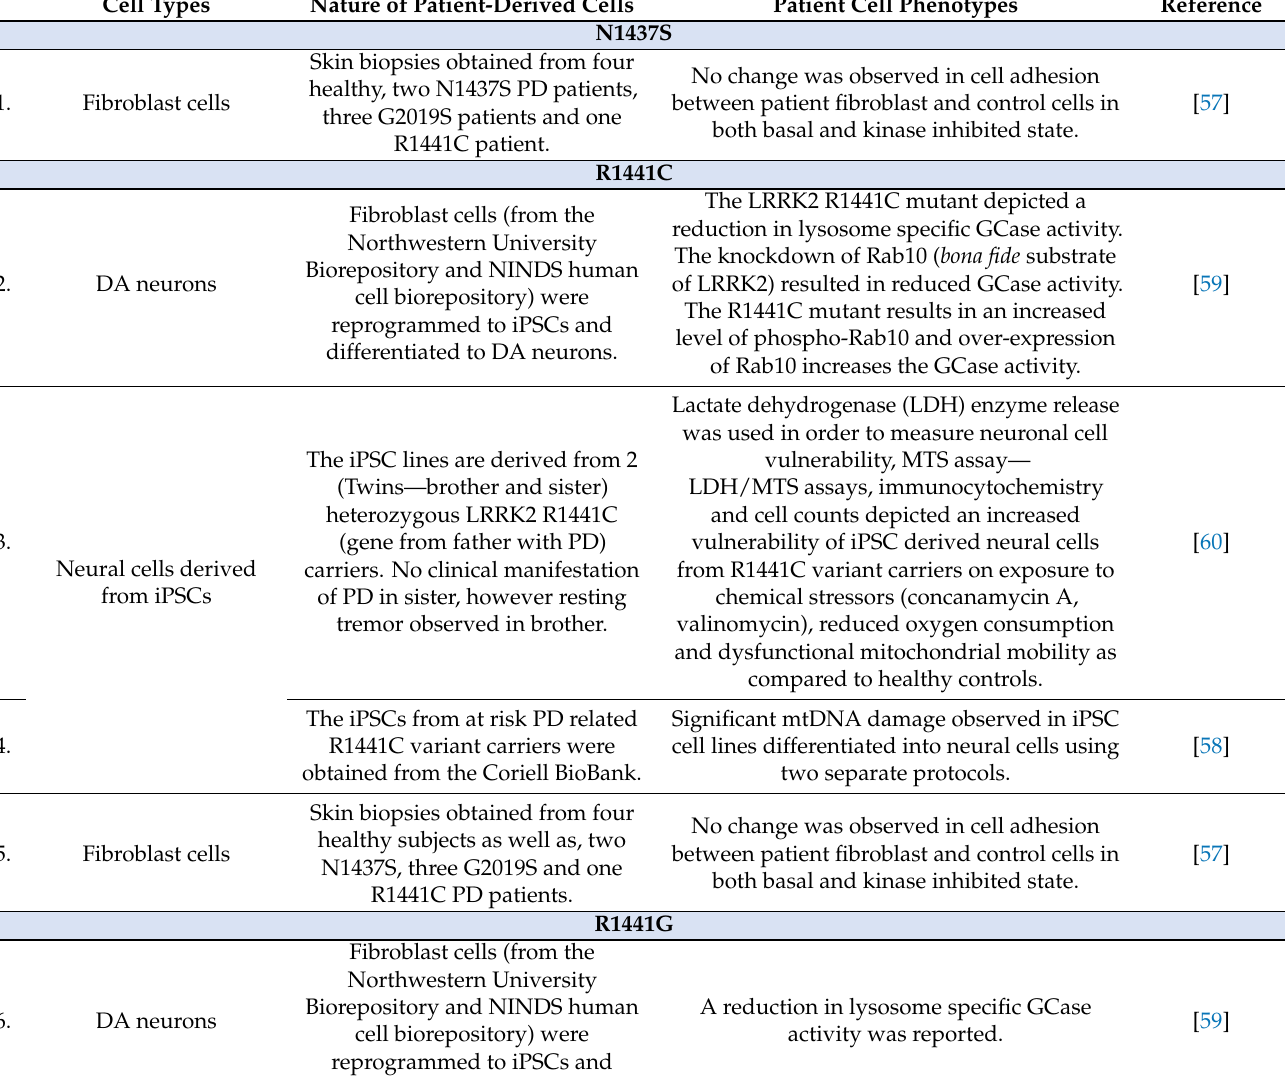
Table 1. An overview of phenotypes observed in cells cultured from patients carrying LRRK2 mutations. Phenotypes of patient-derived cells from individuals carrying LRRK2 mutations as described in published studies are summarized here. Each line of the table corresponds to a single mutation in a single cell type from a single study and provides the test characteristics and main phenotypes